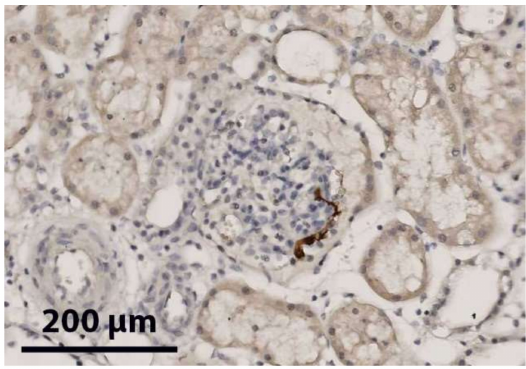
Figure 1. Red / brown immunohistochemical staining of MSCs in one glomerulus in a biopsy of the upper cortex of a kidney after NMP with 10 7 MSCs added.